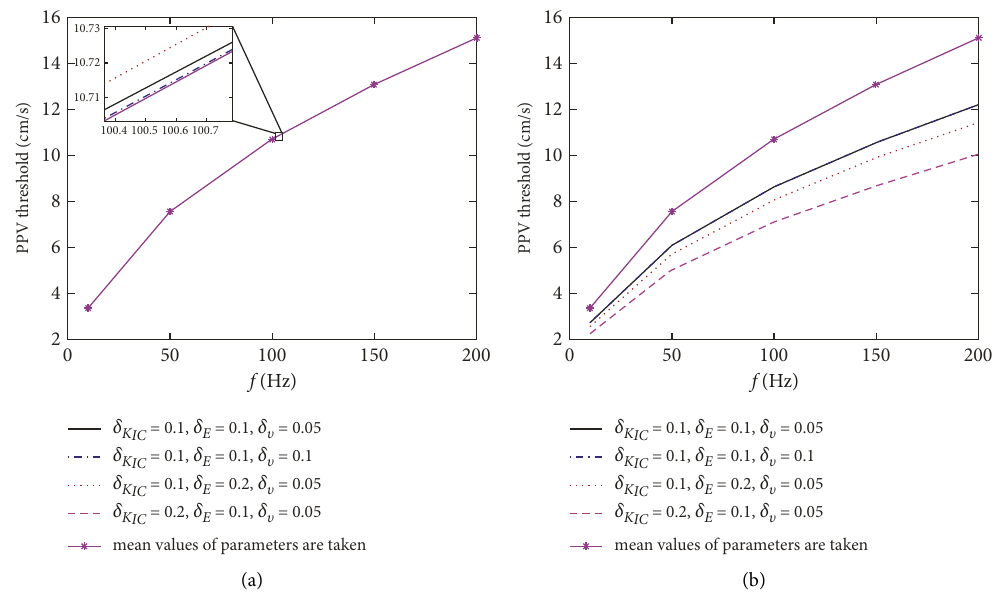
Figure 8: PPV thresholds with different failure probabilities. (a) 50% failure probability and (b) 5% failure